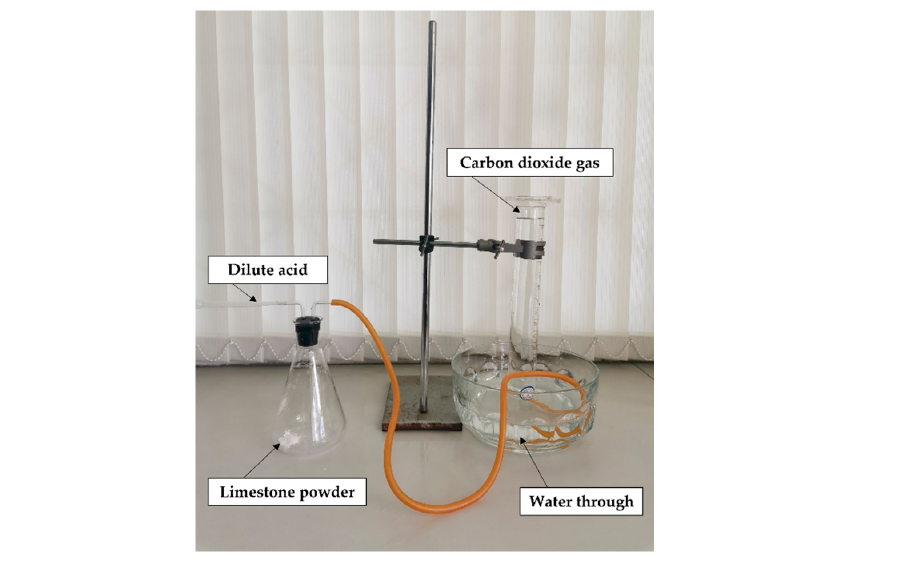
Figure 1. Determination of CO 2 production from limestone and acid reaction.